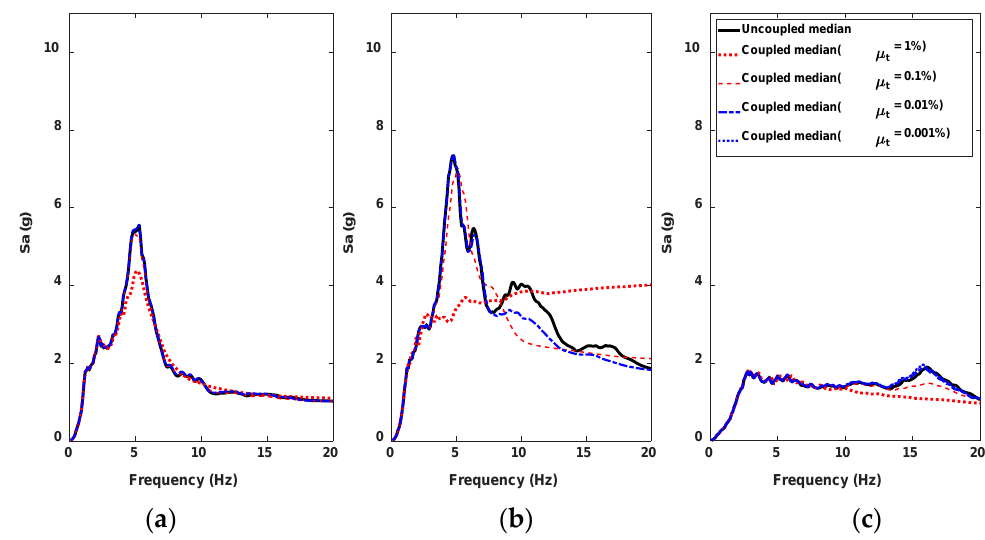
Figure 15. ISRS for 3% equipment damping at the equipment location 4: ( a ) H1; ( b ) H2; ( c ) V.